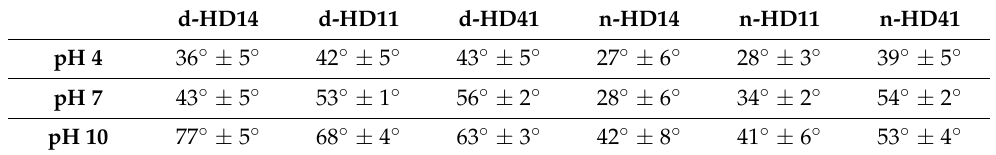
Table 2. Water contact angles of the plasma-polymerized hydrogels after immersion in buffer solutions of pH 4, 7, and 10 for the different pp HD mixture ratios. ( n = 3). d-HD14 d-HD11 d-HD41 n-HD14